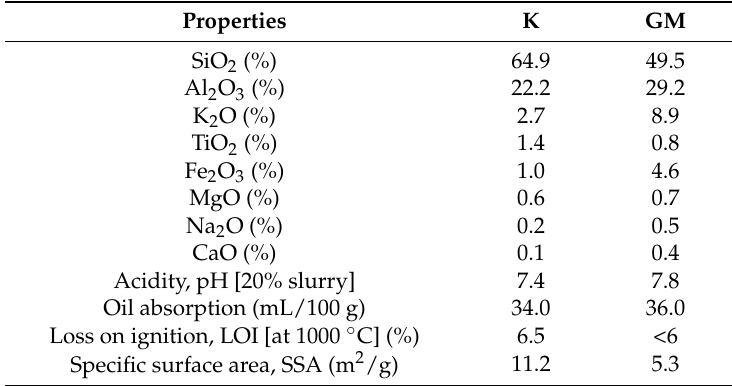
Table 2. Chemical compositions of K and GM (as supplied by the manufacturers).